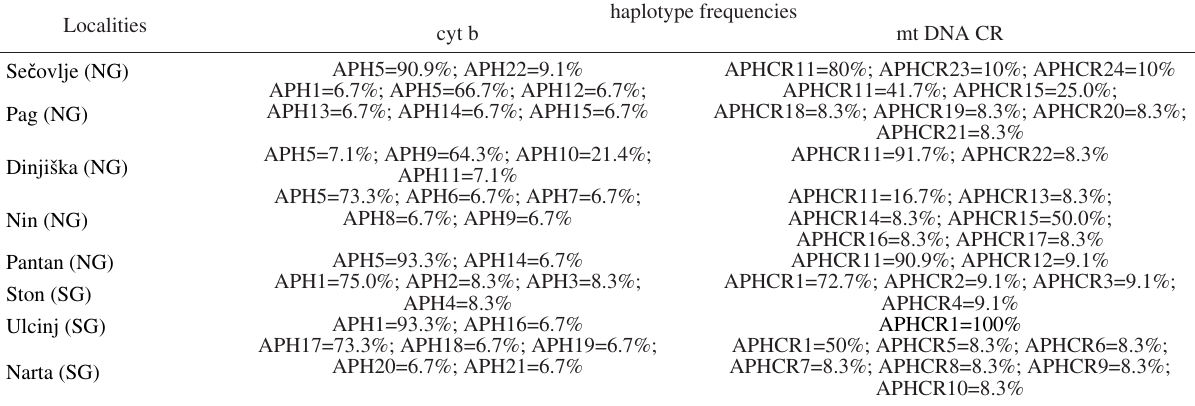
Table S2. – Haplotype frequencies for cyt B and mt DNA CR from the Adriatic localities. NG and SG explain populations belonging to the Northern and Southern groups, respectively